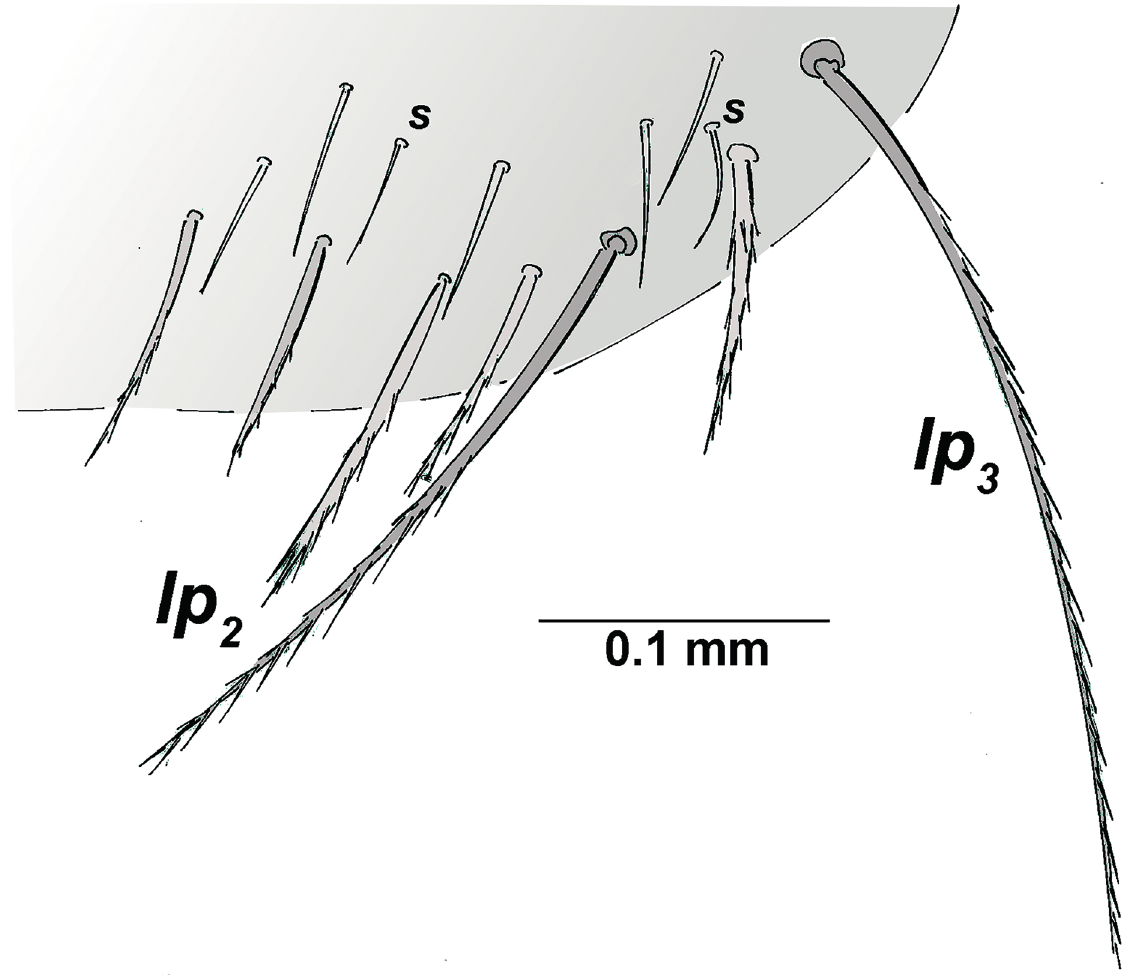
Fig. 29. Turkmenocampa edaphica Sendra & Sánchez-García sp. nov., ♀, holotype (MZB (MCNB) 2021-2340), lateral posterior view of